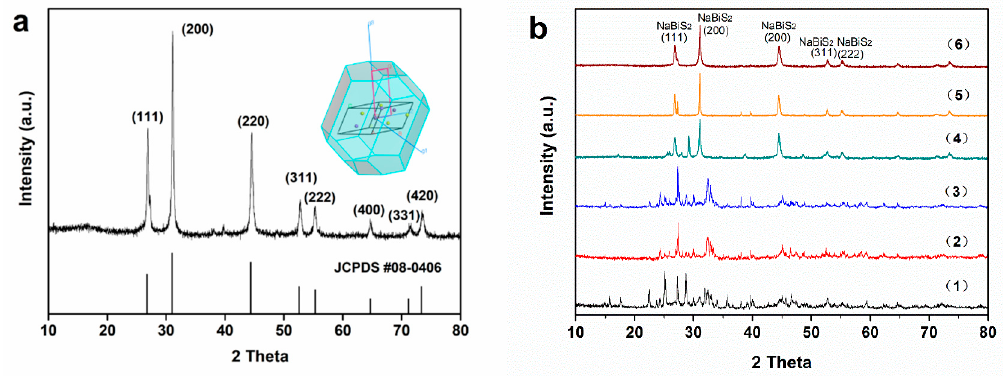
Figure 1. XRD patterns of NaBiS 2 . ( a ) a typical XRD result of NaBiS 2 ; ( b ) XRD results of samples fabricated at various mole ratios of Bi(NO 3 ):Na 2 S:NaOH, (1)1:2:2; (2)1:5:2; (3)1:5:5; (4)1:2:10;